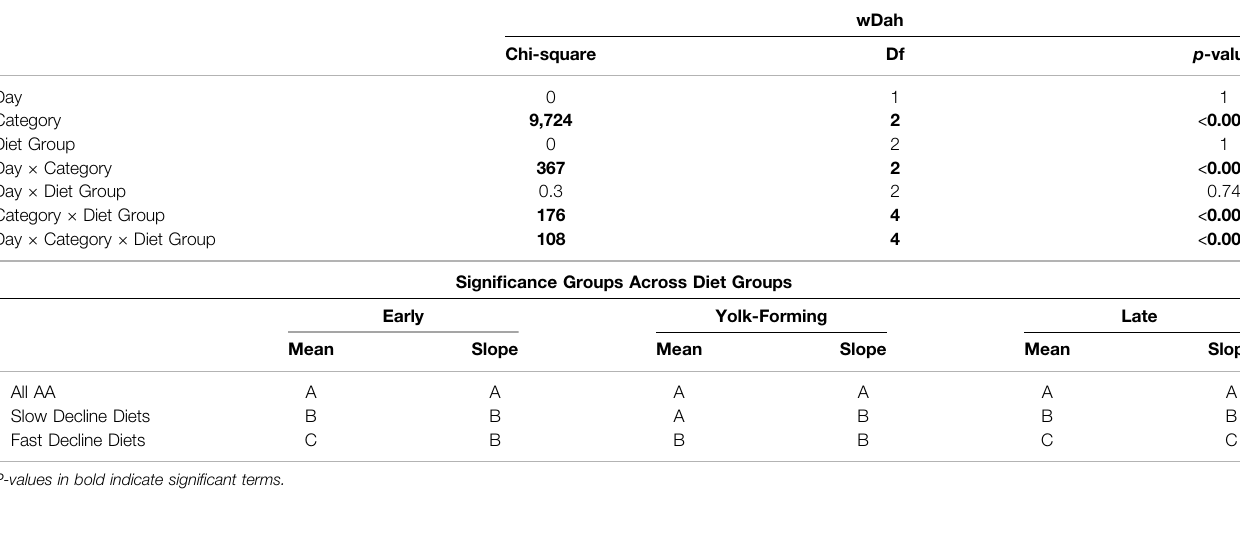
TABLE4| Drop-outdietsthatinduceeitherasloworfastdecline(dietgroup)inegglayingdifferinhowtheyaffectthepercentageofeggchambersineachcategoryovertime inWhiteDahomey(wDah)control fl ies.Categoriesincludeearlystages(eggchamberstage1 – 7),yolk-formingstages(stages8 – 11),andlatestages(12 – 14).Dietgroups that differ in the mean or slope for each category are indicated with different letters.